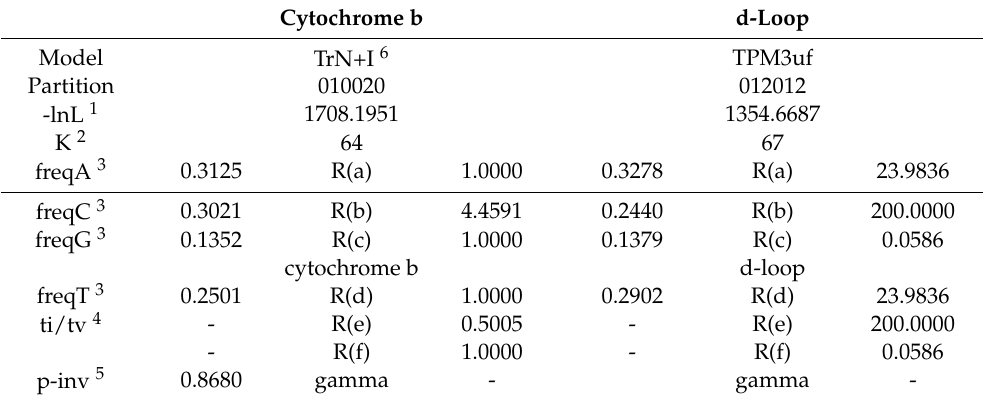
Table 5. The optimal substitution model calculated in the jModelTest program (cytochrome b and d-loop).